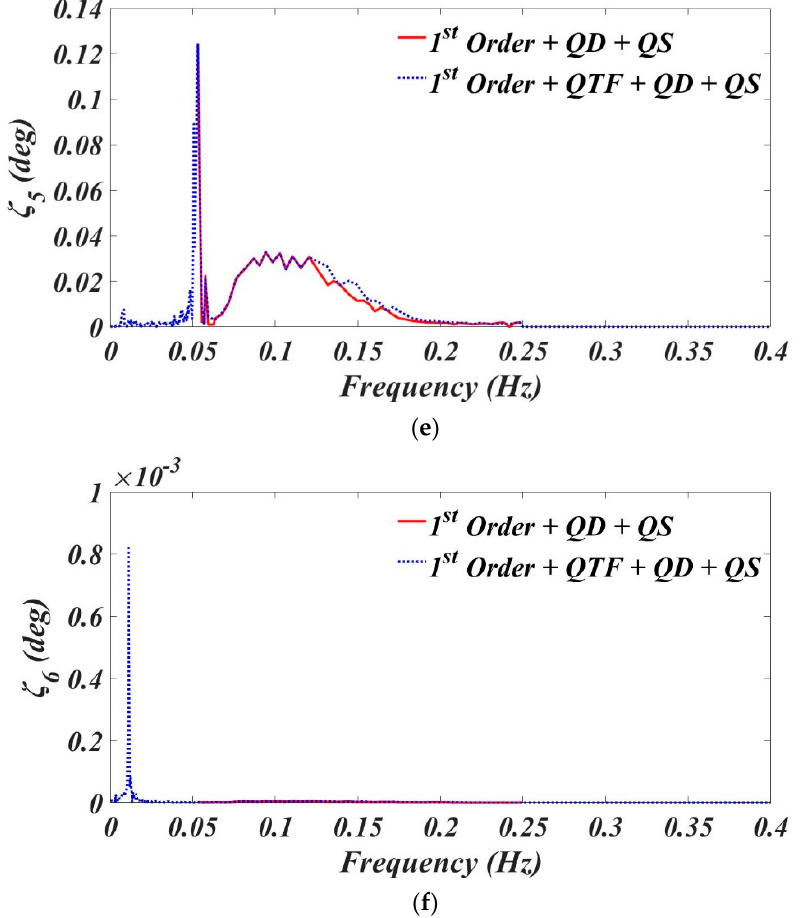
Figure 12. The effects of the QTFs on the motion responses in ( a ) the surge, ( b ) the sway, ( c ) the heave, ( d ) the roll, ( e ) the pitch, and ( f ) the yaw modes, respectively.